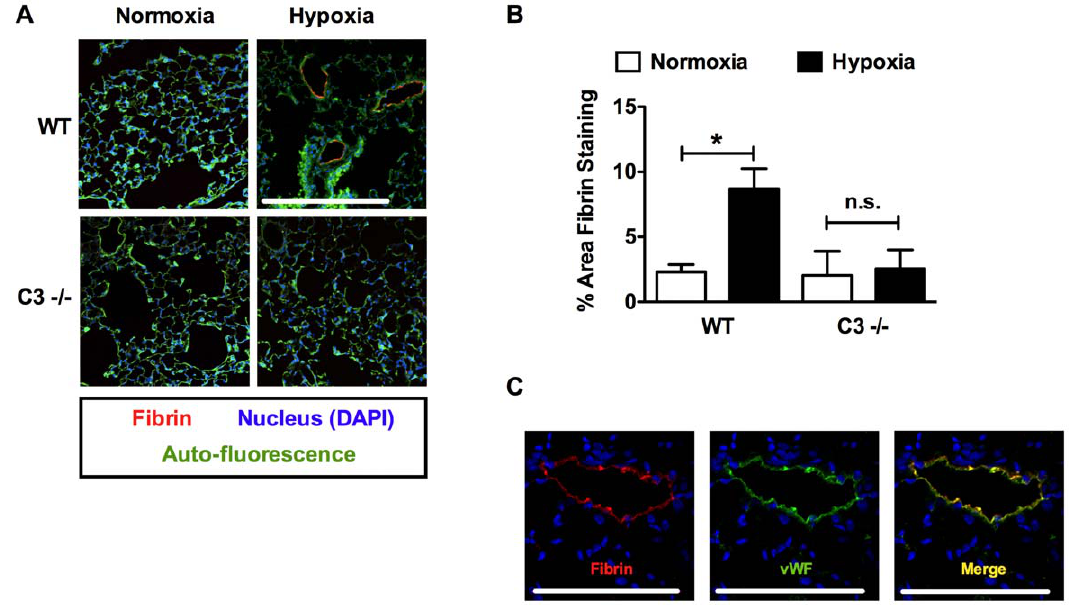
Figure 10. Decreased fibrin deposition in hypoxic C3 2 / 2 mice. (A) Representative images of lung sections from normoxic or hypoxic WT or C3 2 / 2 mice stained for fibrin(ogen) and nuclei (DAPI). Scale bar represents 150 m m. (B) % Area fibrin staining per total lung area (n=4) in hypoxic or normoxic WT or C3 2 / 2 mice. (C) Representative photomicrograph of WT hypoxic mouse lung showing colocalization (yellow to orange) of Fibrin (green) and vWF (red). Scale bar represents 50 m m. (A, B, E). Bars represent the mean 6 SD. * P , 0.05; n.s.=not